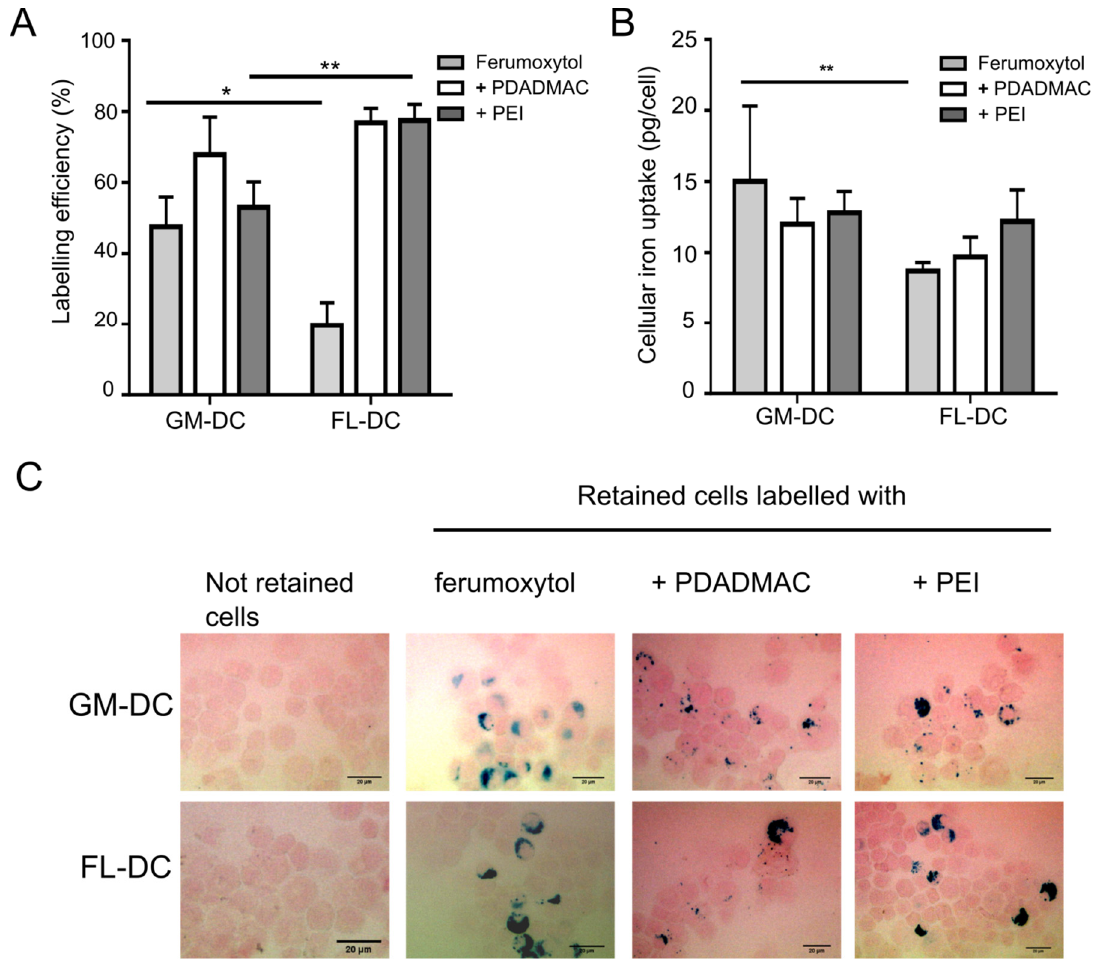
Figure 3. Uptake of uncoated and PE-coated ferumoxytol particles into DCs. Inflammatory DCs (GM-DCs) and steady-state DCs (FL-DCs) were incubated with the respective MNPs for 24 h and subjected to magnetic separation of MNP-loaded cells from unlabeled cells. ( A ) Labeling efficiency was determined from the numbers of retained and not-retained DCs after magnetic separation. ( B ) Intracellular iron concentration (pg/cell) of retained DC fractions after magnetic separation. Results in ( A , B ) are mean values ± SD ( n = 3; *: p < 0.05; **: p < 0.01). ( C ) Prussian blue staining of cytospins of magnetically retained and not-retained cells for detection of iron deposits. Neutral red dye was used as counterstain. Scale bars, 20 µ